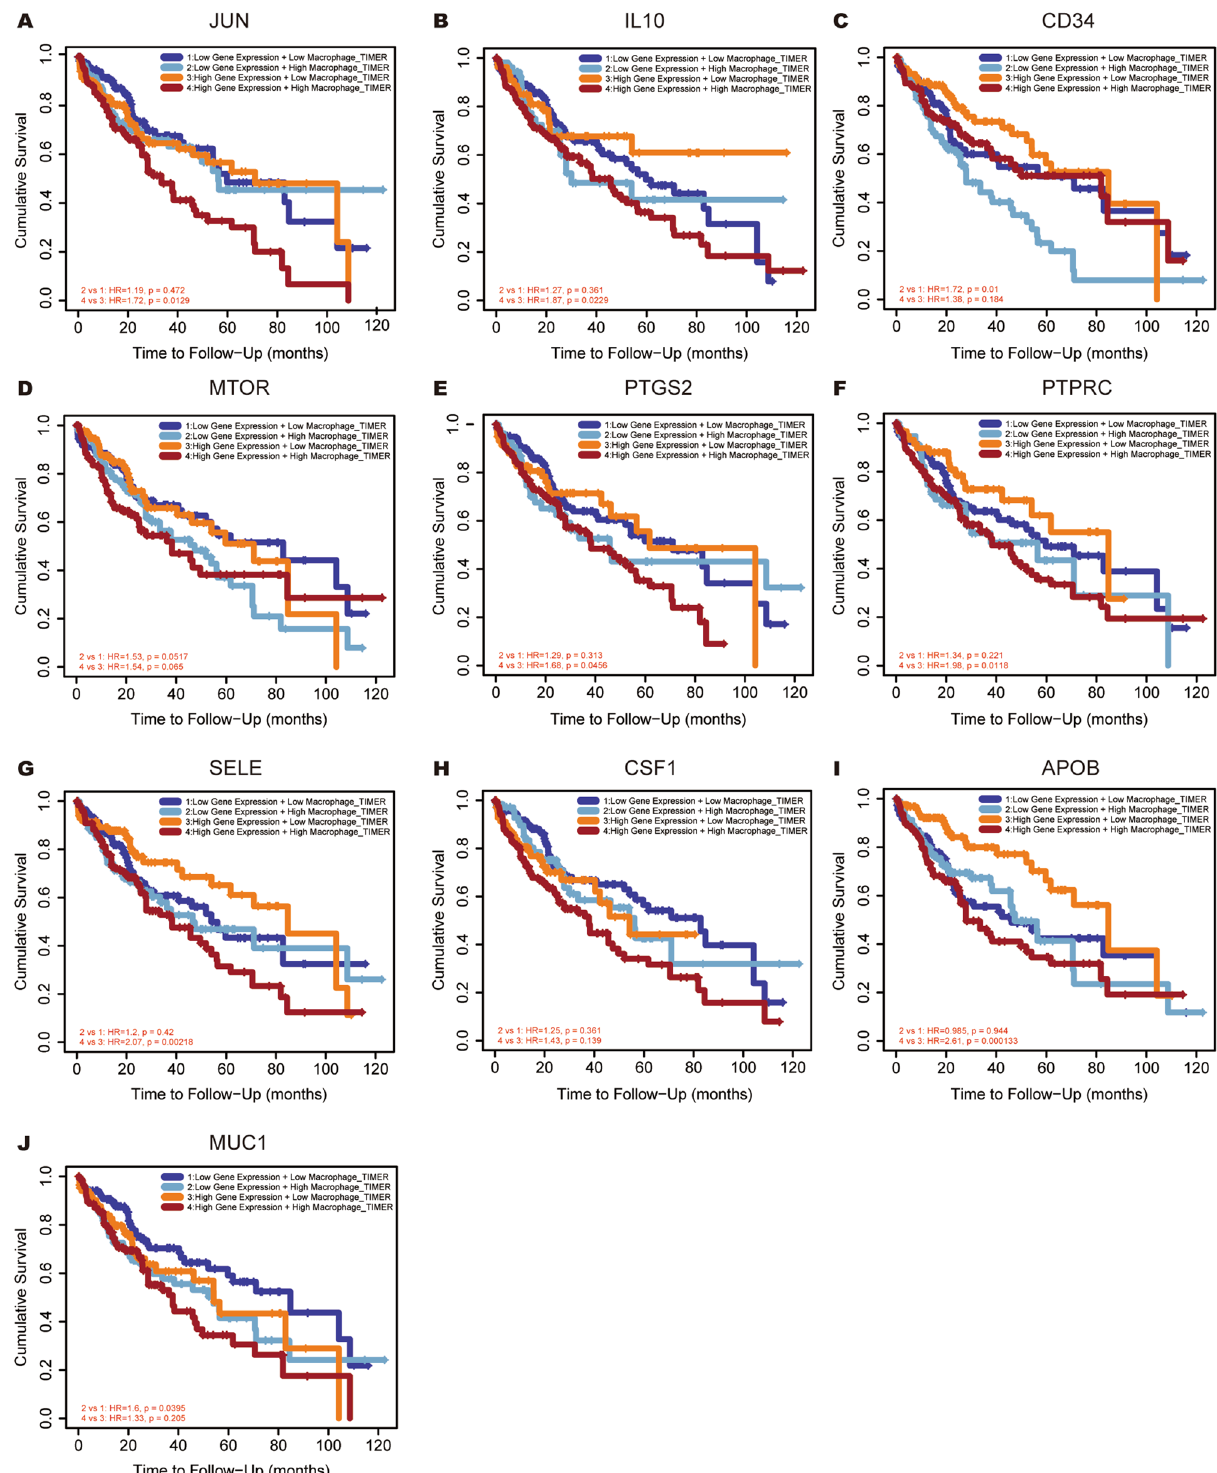
Figure 11. Overall survival analyses for combining the expression of single hub gene with macrophage in HCC patients. ( A ) JUN, ( B ) IL10, ( C ) CD34, ( D ) MTOR, ( E ) PTGS2, ( F ) PTPRC, ( G ) SELE, ( H ) CSF1, ( I ) APOB, ( J )